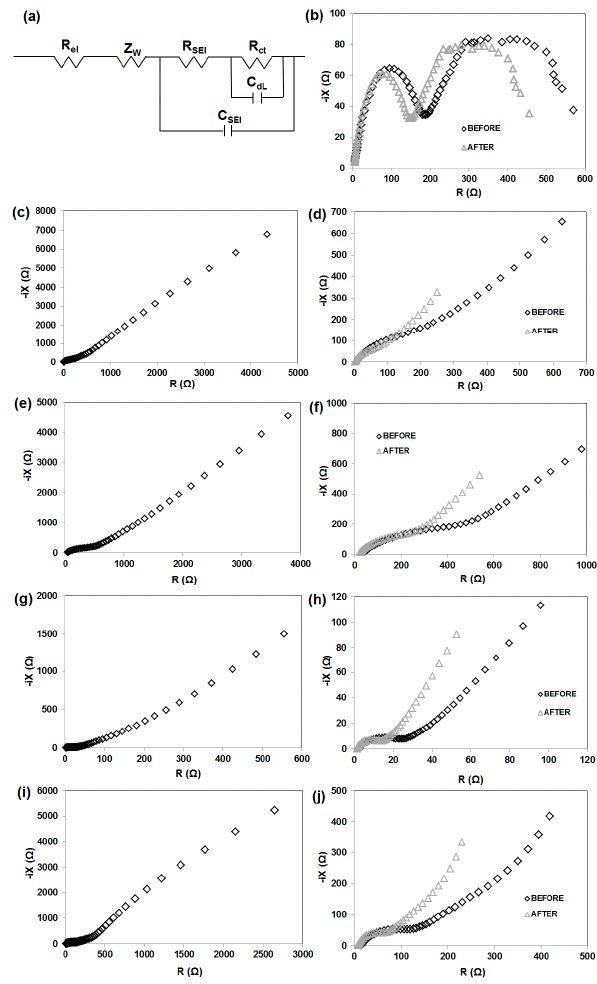
Figure 13. Equivalent electrical circuit ( a ), and EIS measurements of MnO 2 |Li ( b ), KL|Li ( c ) MnO 2 /KL+A|Li ( e ), MnO 2 /KL+B|Li ( g ) MnO 2 /KL+C|Li ( i ); plots magnification before and after charging-discharging for KL|Li ( d ) MnO 2 /KL+A|Li ( f ), MnO 2 /KL+B|Li ( h ) and MnO 2 /KL+C|Li ( j ) systems.